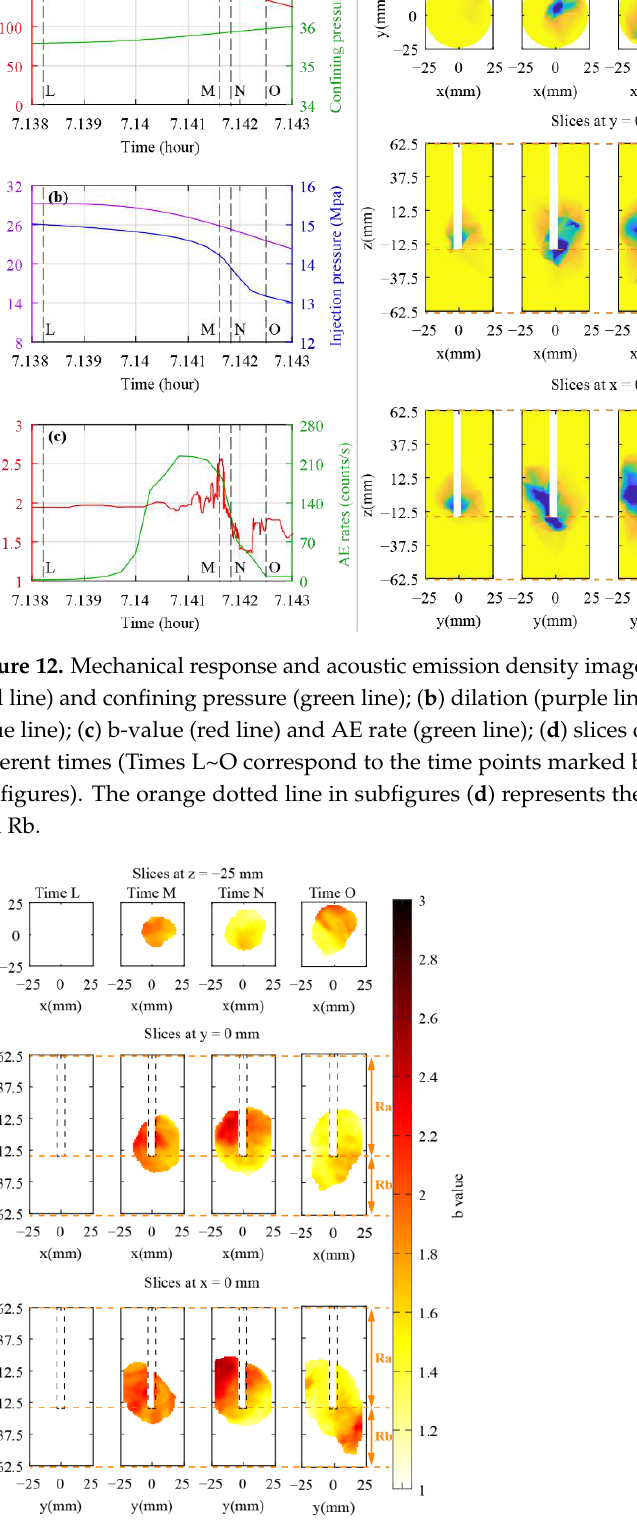
Figure 13. Spatio-temporal evolution of b-value in H2 phase. The orange dotted line represents the boundary between region Ra and Rb. The dotted box represents the region with borehole.